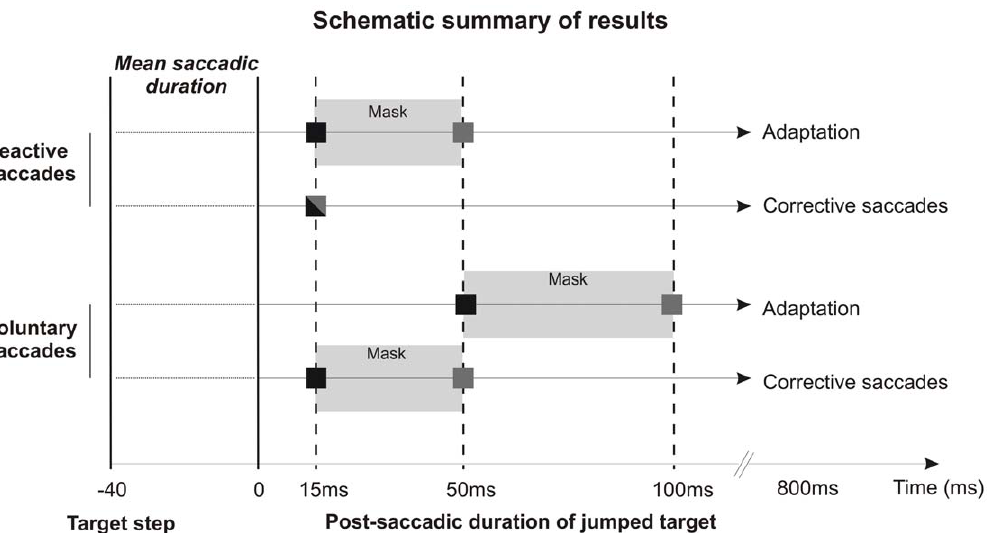
Figure 6. Schematic representation of the results. This schema represents the differences in error signal processing between saccade categories and between adaptation and corrective saccade generation. Each square indicates the minimal target duration leading to optimal adaptation or to optimal generation of corrective saccades, for both saccade categories. The shading of the square represents the masking condition in which this target duration is required: grey square for the mask condition and black square for the no-mask condition (bicolour square when the same target duration is required in both masking conditions). The grey rectangles ‘‘Mask’’ symbolise the fact that when the mask is presented, a longer duration of stepped target is necessary to induce optimal adaptation and corrective saccade generation.